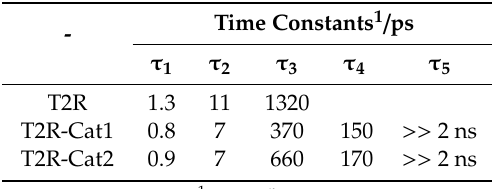
Table 1. Characteristictimeconstantsoflight-inducedprocessesuponexcitationat480nm. Thecorresponding rates are given in Table